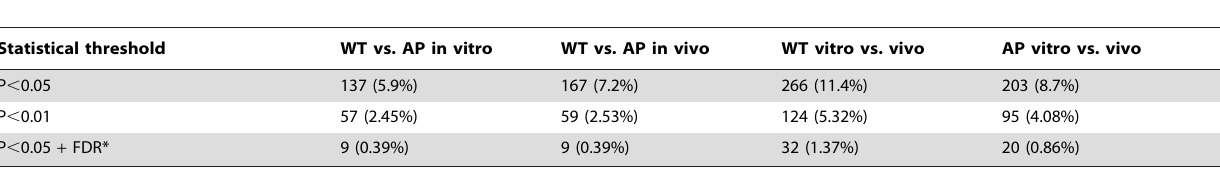
Table 2. Number and percentage of genes significantly different between each pair of conditions at different significance